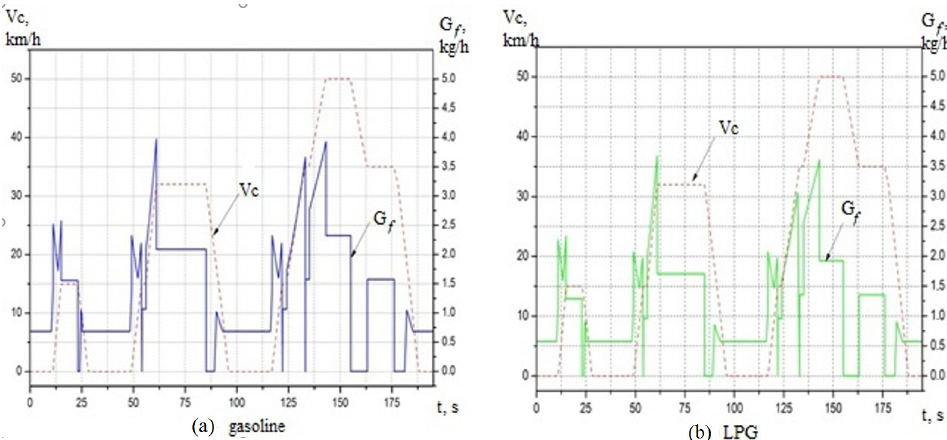
Figure 4. Conditional speed of the car and hourly fuel consumption during the execution of a fragment of the driving cycle (mathematical model) of gasoline ( a ) and LPG ( b )